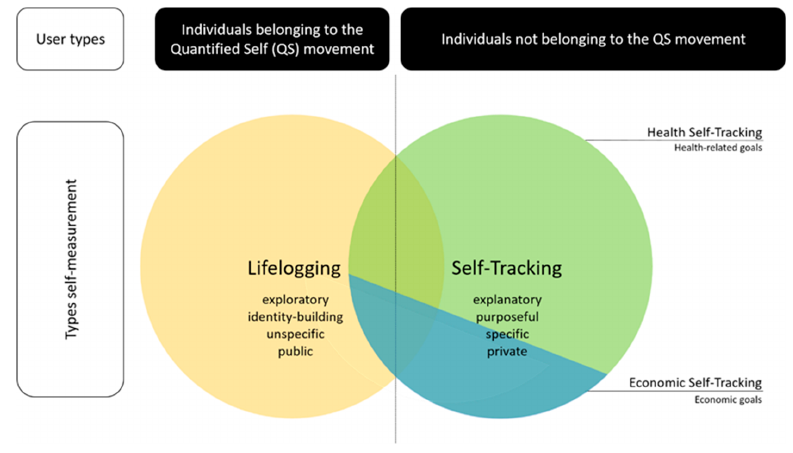
Figure 1. Self-measurement framework.